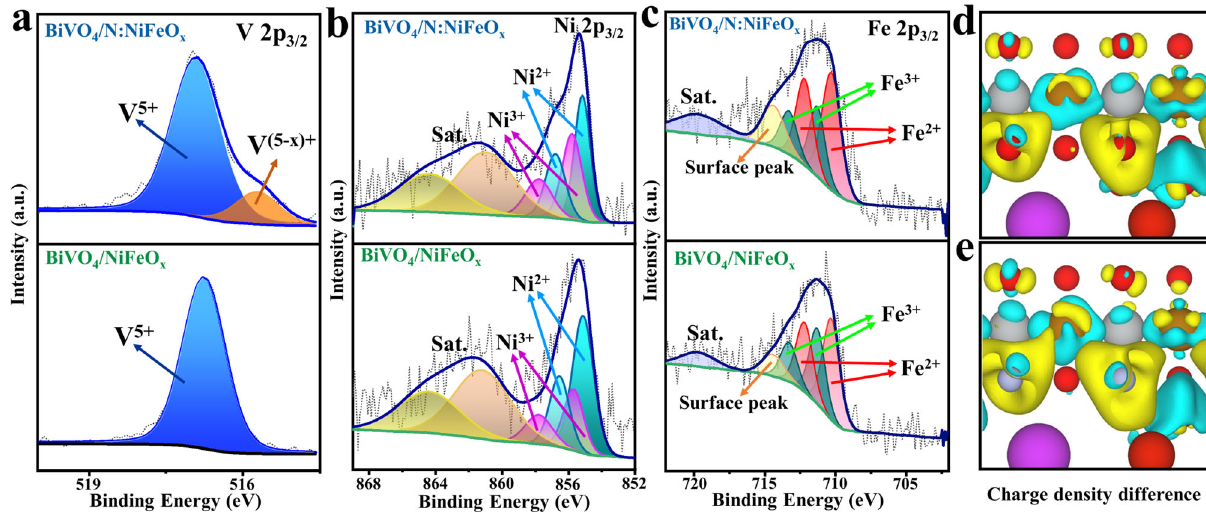
Fig. 4 Effects of N-incorporation on the surface chemical states and electronic structures of BiVO 4 /NiFeO x . XPS high-resolution a V 2p, b Ni 2p, and c Fe 2p spectra for BiVO 4 /N:NiFeO x and BiVO 4 /NiFeO x photoanodes, respectively. Schematic of charge density difference (yellow and cyan represent charge accumulation and depletion, respectively; the cut-off of the density-difference isosurface is 0.01 Å − 3 ) of BiVO 4 /NiFeO x ( d ) and BiVO 4 /N:NiFeO x ( e